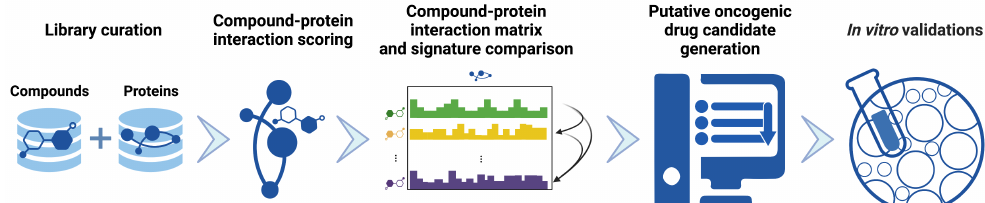
Figure 2. Precision drug discovery pipeline within CANDO for generating novel drug leads for KRAS G12C NSCLC. We created a pipeline within the previously developed CANDO platform [21–34] to generate drug candidates based on novel applications of existing drugs/compounds using four approved or investigational treatments for KRAS G12C NSCLC (AMG-510/sotorasib, ARS-1620, MRTX-849/adagrasib, BAY-293). Our hypothesis is that these drugs/compounds may be used to identify other behaviorally similar drugs/compounds that could (also) be effective against KRAS G12C NSCLC, either individually or synergistically. Interaction scores between every compound in our 13,218 drug/compound library and every protein in our 5317 human pro- teome library were first calculated using bioanalytical docking. This resulted in a compound- proteome interaction signature for each drug/compound, i.e., a vector of 5317 scores that de- scribes the functional behaviour of the compound, shown here with proteins depicted horizon- tally, and compounds vertically as an interaction matrix (Section 3.3). Compound-compound behavioral similarity was then calculated by comparing individual compound-proteome interac- tion signatures using the cosine distance and benchmarked with known data to ensure optimal performance (Section 3.4). Putative drug candidates were then generated from the drugs/compounds with the most similar pairwise interaction signatures to those belonging to investigational and approved treatments of KRAS G12 NSCLC (Section 3.5). Signature comparison results indicated that osimertinib was most similar to KRAS inhibitor BAY-293, and highly similar to KRAS